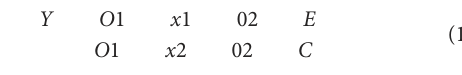
Figure 2 indicates the picture of the design. Table 1 represents the design of the